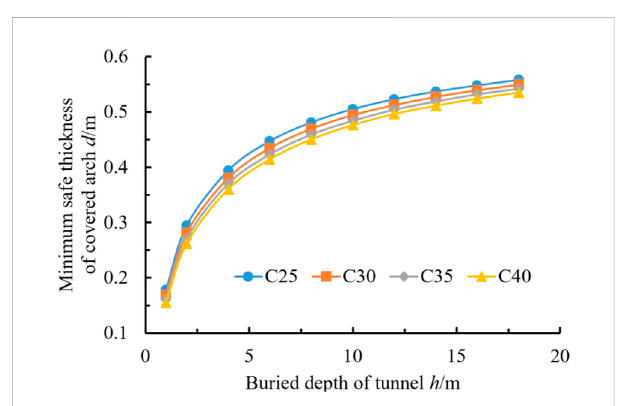
FIGURE 11 Relationship between thickness and tunnel depth with different concrete strength